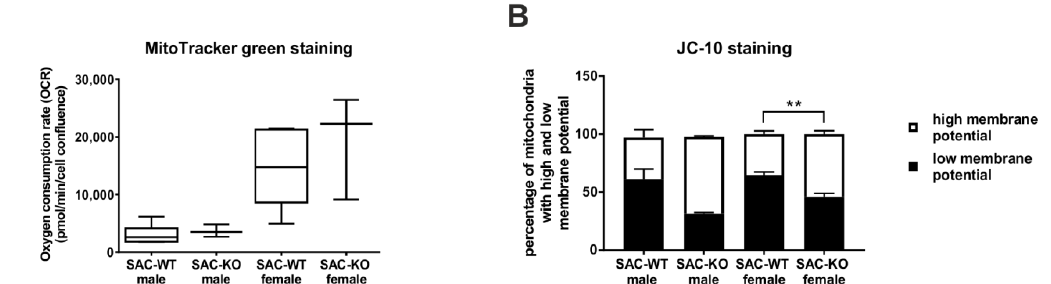
Figure 2. Effect of hepatocyte-specific Hedgehog knockout on mitochondrial mass and membrane potential. ( A ): Mitochondrial mass of SAC mice. ( B ): mitochondrial membrane potential. Error bars show the standard error of the mean (SEM). Significance was calculated with multiple t-test. Stars show the significance to WT animals. ** p ≤ 0.01; n = 2–7.